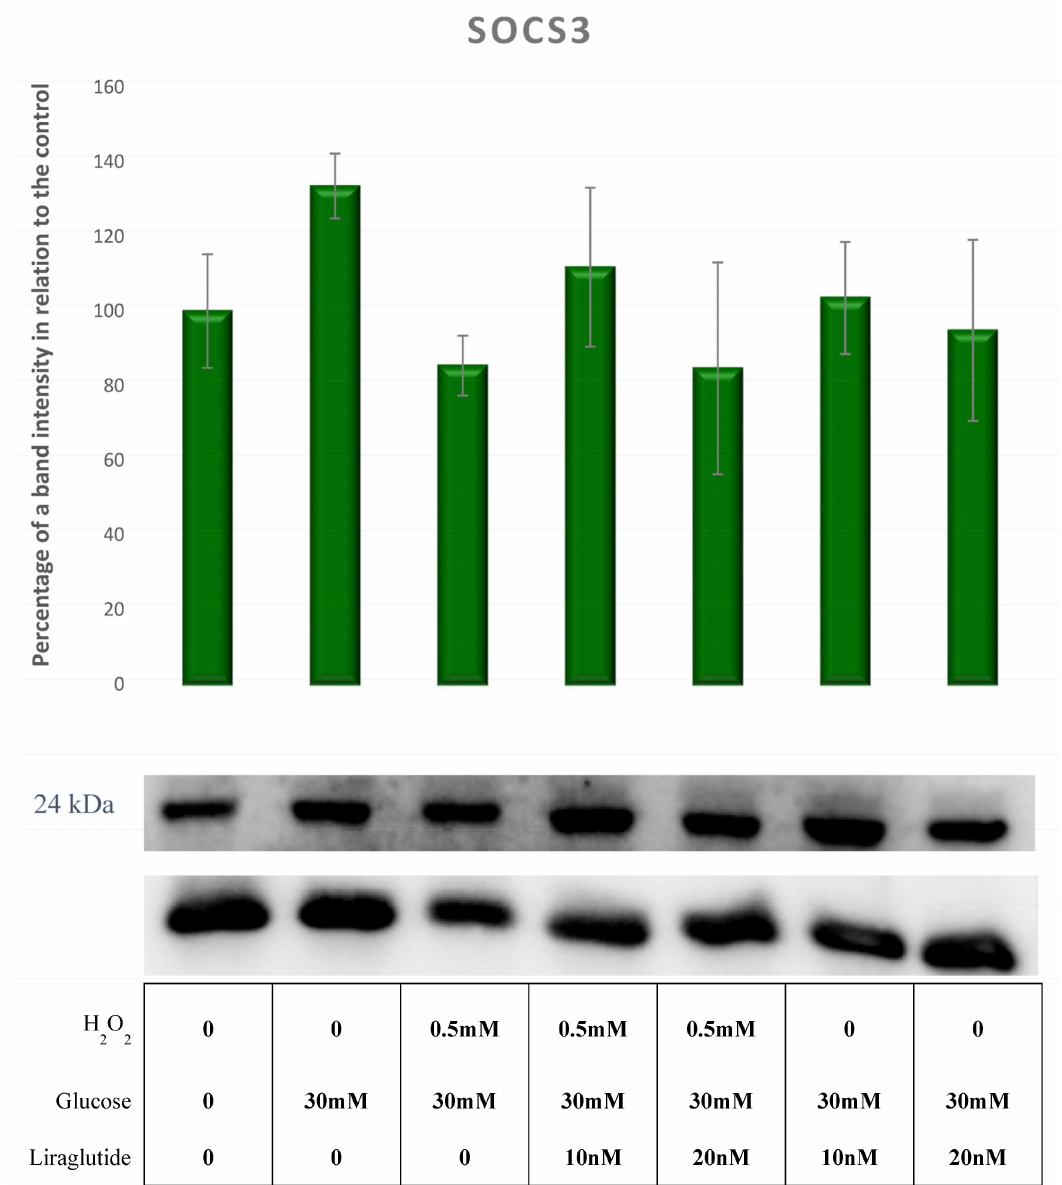
Figure 13. Protein expression in the LLC-PK1-treated cell line (control vs. HG30 and HG30/H 2 O 2 ; HG30 vs. HG30/Lira10 and HG30/Lira 20; HG30/H 2 O 2 vs. HG30/H 2 O 2 /Lira10 and HG30/H 2 O 2 /Lira 20) determined by Western blot. Glyceraldehyde 3-phosphate dehydrogenase (GAPDH) was used as an internal control. The data are shown as the means ± SD (standard deviation) from three independent biological replicates. One-way ANOVA F(6,20) = 0.819, p = 5.73 × 10 − 1 with Tukey HSD post hoc test. Values underneath the x axis represent the amount of compound added in the experiment, and 0 represents that the compound was not added. Protein expression, pig proximal tubule cell line (LLC-PK1), HG (1.5 mM, 30 mM), H 2 O 2 (0.5 mM), Liraglutide (10 nM, 20